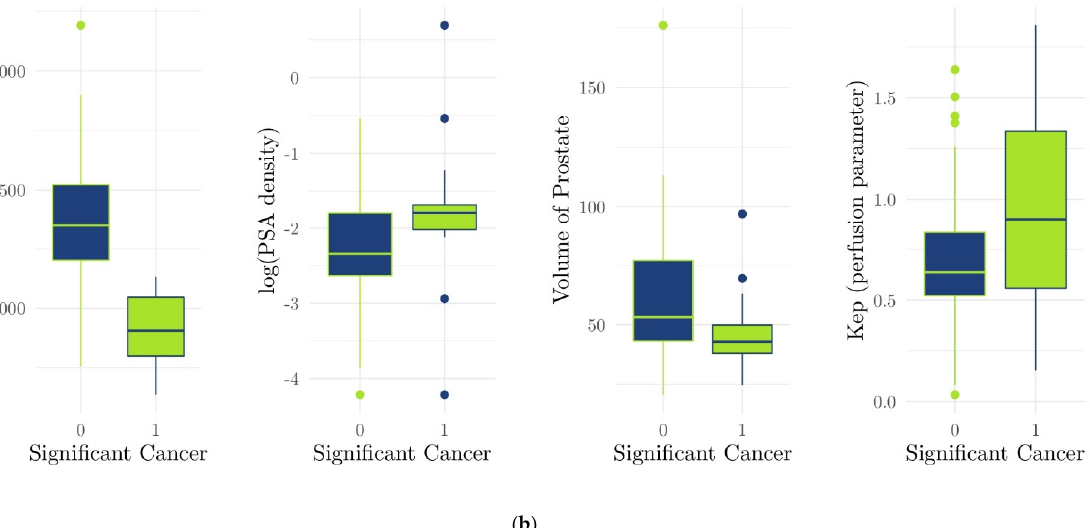
Figure 7. ( a ) and ( b ) Performance of clinical and imaging parameters to discriminate between csPCa and non-csPCa. Of all clinical and functional imaging parameters, the diffusion parameters ADC mean/min had the best discrimination ability for the presence of a significant (green) or non-significant tumor/no tumor (blue) in the peripheral zone. Adjusted p-values for each variable are as follows: p(ADC mean ) = <0.001, p(log(PSA density )) = 0.428, p(VolumeProstate) = 0.024, p(K ep ) = 0.249.